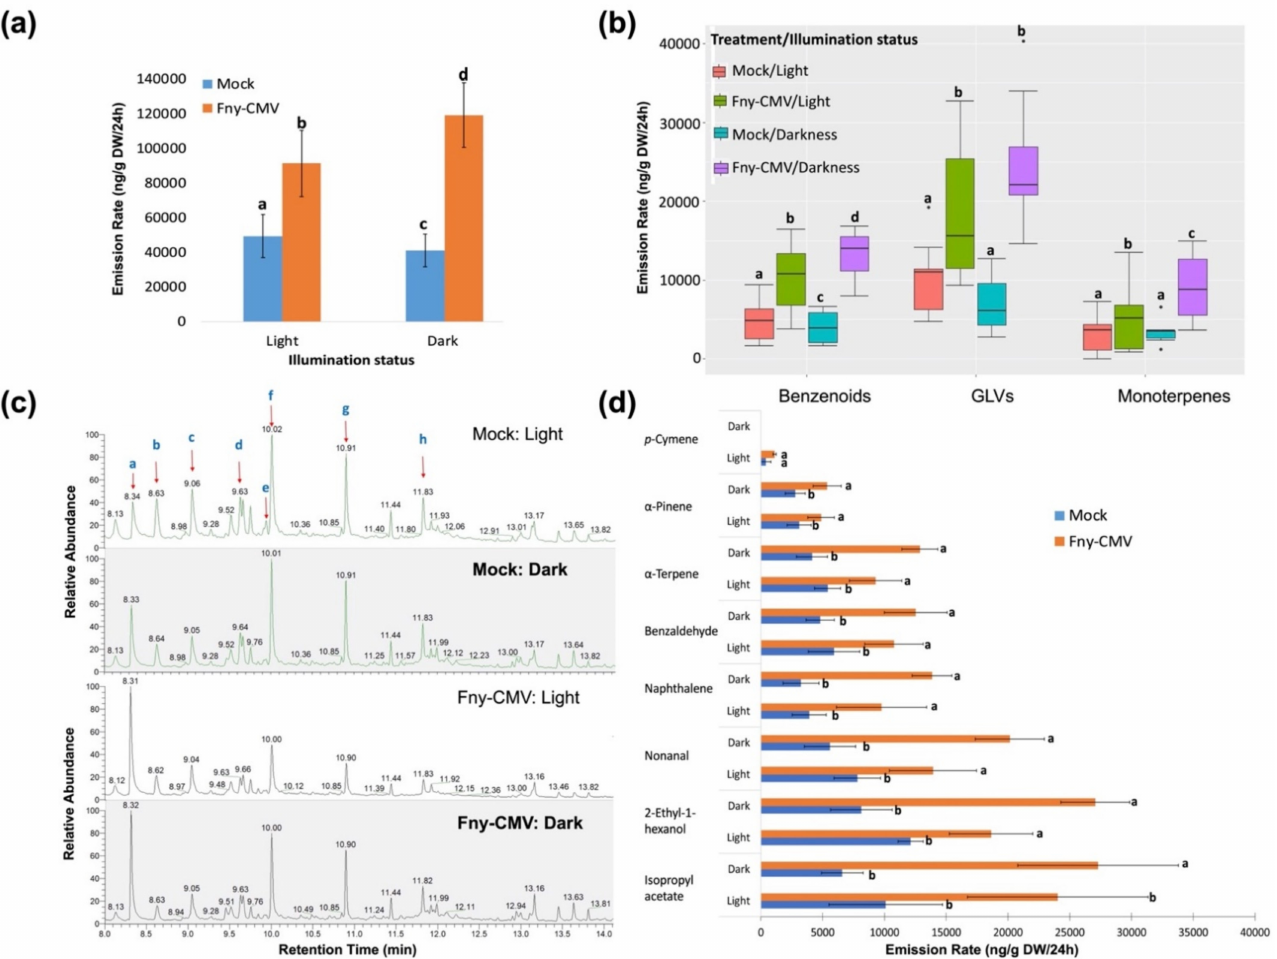
Figure 4. Analysis of volatile organic compounds (VOCs) emitted by infected and mock-inoculated tomato plants in darkness or under illumination. Gas chromatography and mass spectrometry were used to detect quantitative and qualitative differences in the VOCs emitted by mock-inoculated tomato plants or plants infected with Fny-CMV (at 21 days post-inoculation) and collected by dynamic headspace trapping. Quantitative differences in overall VOC emission ( a ) and for specific groups of VOCs: benzenoids, green leaf volatiles (GLVs), and monoterpenes ( b ). ( c ) Chromatograms of VOCs from tomato plants that had been mock-inoculated (upper two chromatograms) or infected with Fny-CMV (lower two chromatograms) under light and dark conditions. Blue lettering on the uppermost chromatogram indicates peaks for abundant VOCs emitted by mock-inoculated